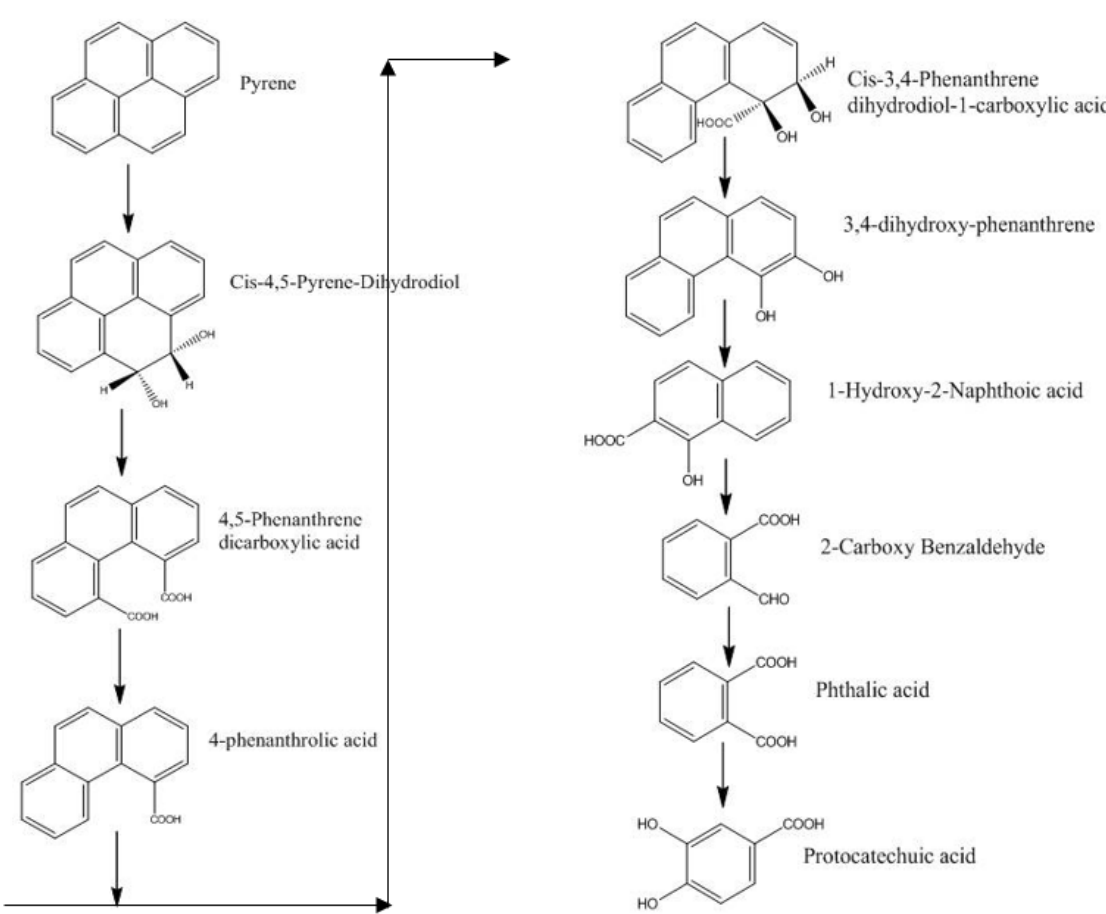
Figure 3. Mycobacterium spp., KR2 strain bacterial degradation path of pyrene [165,170].